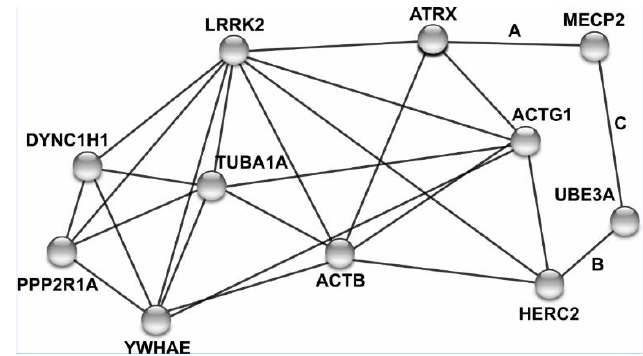
Figure 6. Network of LRRK2 and eight interacting proteins linked to intellectual disability. Human protein names are adjacent to nodes, with edges linking nodes based on physical interactions, co-expression, or other experimental evidence. All nodes connected to LRRK2 mark a physical protein–protein interaction. Letters A–C next to edges mark associations identified via BioGRID and a primary literature search but were not initially included in the STRING network [33–35].